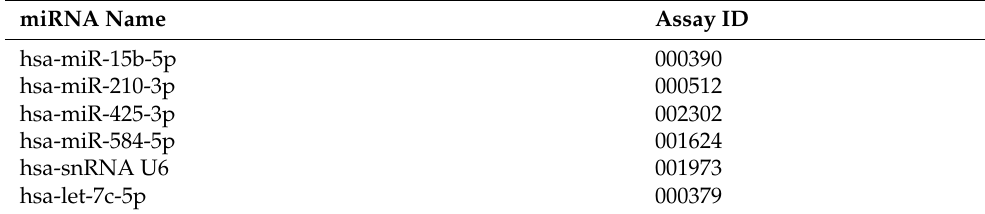
Table 1. Complete list of the employed miRNA-TaqMan